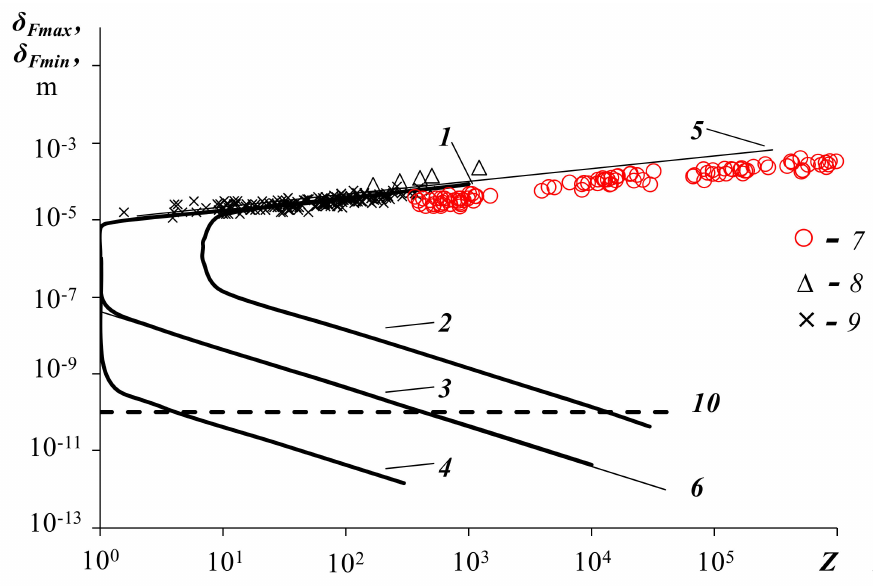
Figure 6. Diagram of states of a drop-ion plasma. (1) is the distance between the surfaces of the nearest drops δ F max at the points of the local maximum of free energy depending on the charge of the drops Z . (2), (3), and (4) are the distance between the surfaces of the drops δ F min at the points of the local minimum of the free energy, the radii of the drops are 10 − 5 , 10 − 6 and 10 − 8 m, respectively. (5) and (6) are approximating curves. (7)—experimental values for drops on a hydrophobic surface, (8)—the same for a drop cluster, and (9)—the same for water fog. (10) is the distance between the droplet surfaces at which coalescence